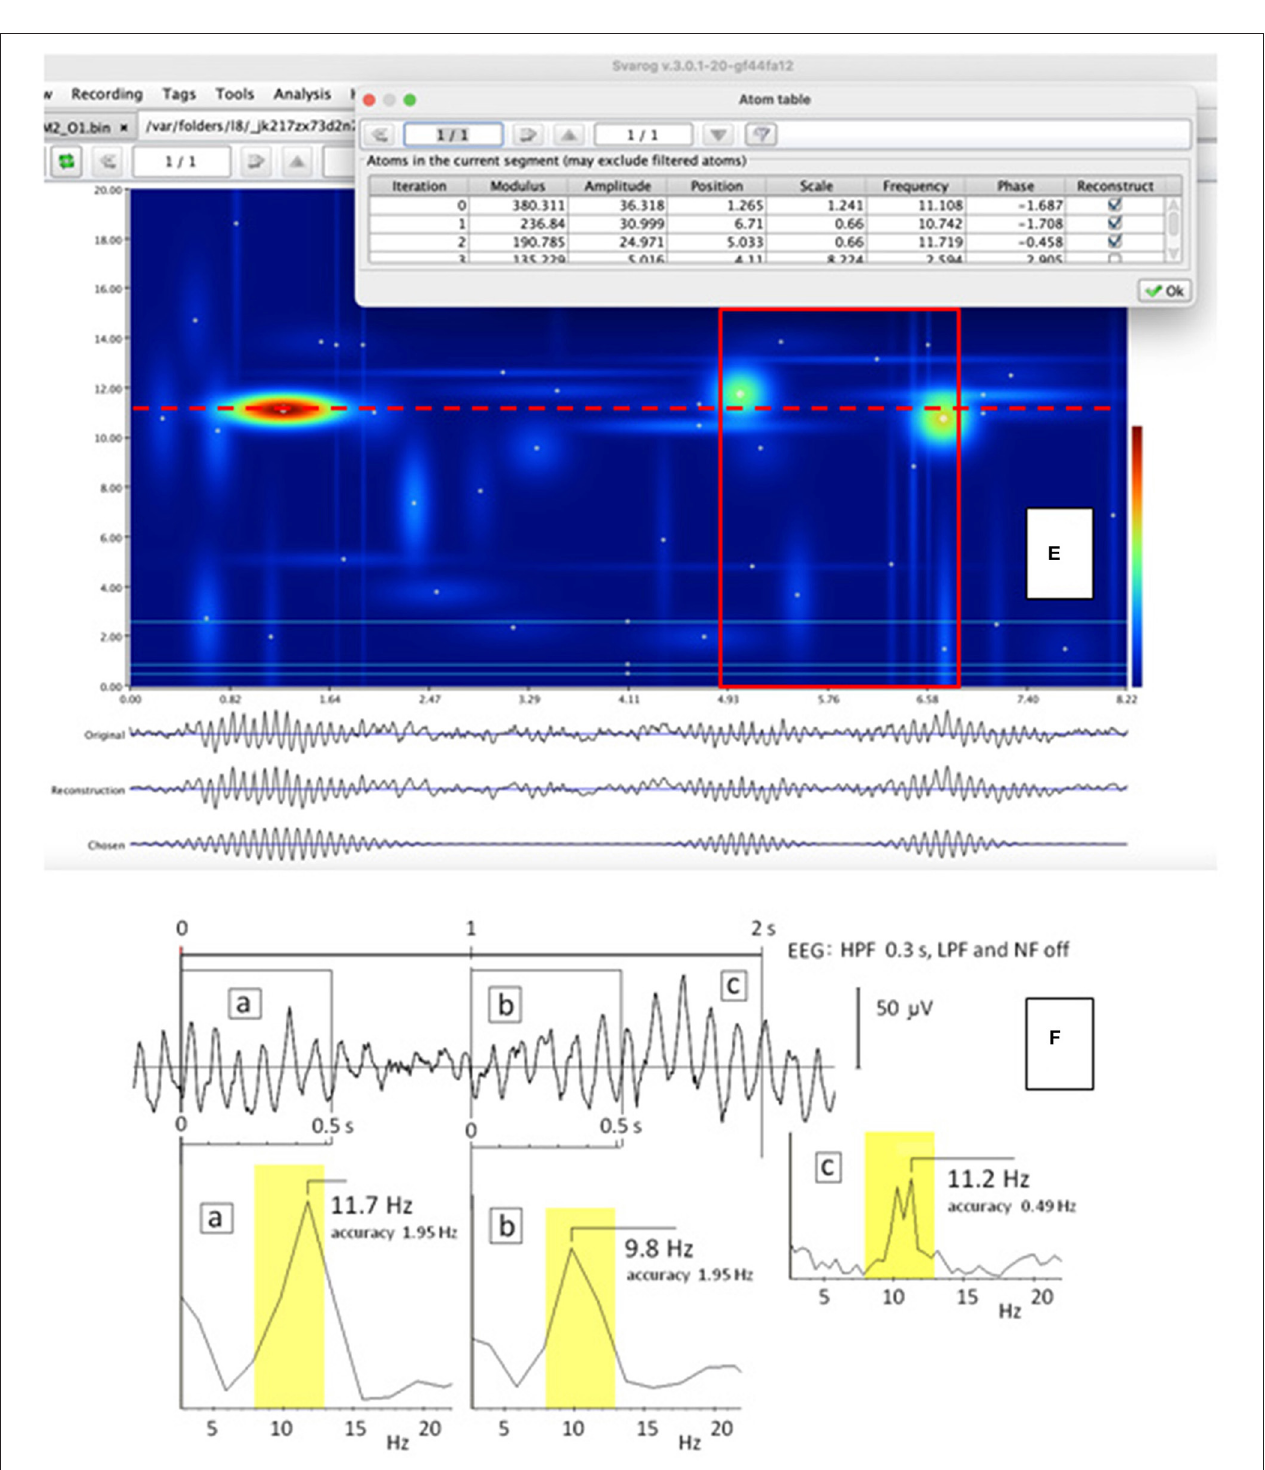
FIGURE 1 | (A) EEG segment with relatively stable pattern of the alpha split; a, b, c – the FFT calculated for 2-, 4-, and 8-s windowed segments of the EEG record starting at time zero; (B) EEG segment (from Figure 1 presented in our original paper) recorded in another person; a, c – the FFT (upper panel) and the relative power spectrum (lower panel) calculated for two 2-s windows in time ranges from 0 to 2s and from 5 to 7s, respectively. The FFT and the EEG windows had the same size; b – the FFT calculated for the 8-s EEG segment; (C–F) the instantaneous frequency (C) , the Empirical Wavelet Transform with the Hilbert Transform (D) , and the Matching Pursuit method (E) and the FFT (F) calculated for the same EEG segment as in (B) . The 2-s window in which the split alpha was visible in (B- c), was marked as the red rectangle.